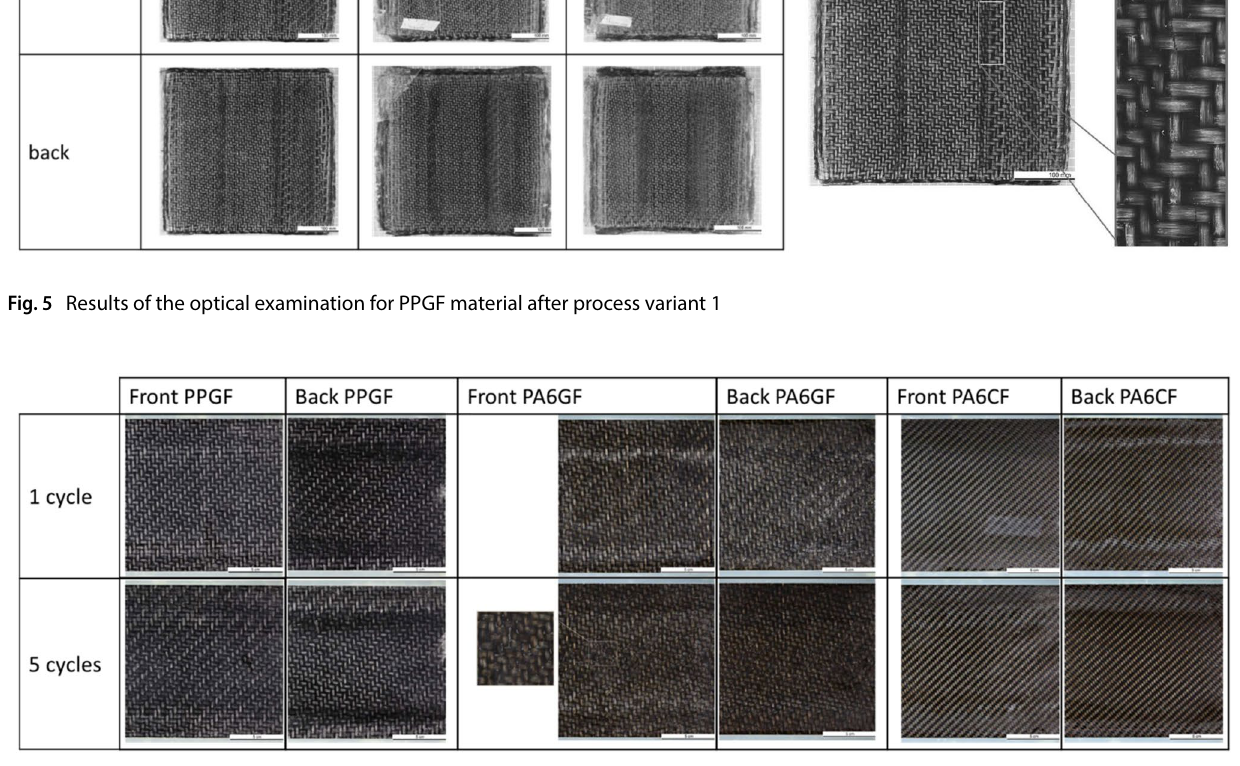
Fig. 6 Results of the optical examination for PPGF, PA6GF and PA6CF material after process variant